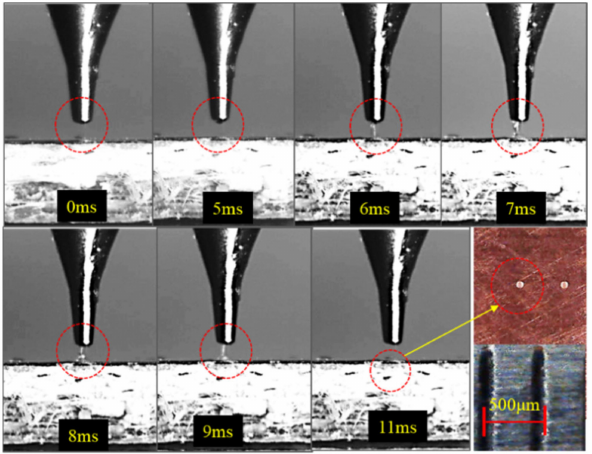
Figure 6. Image of Taylor cone generation and droplet eject deposition